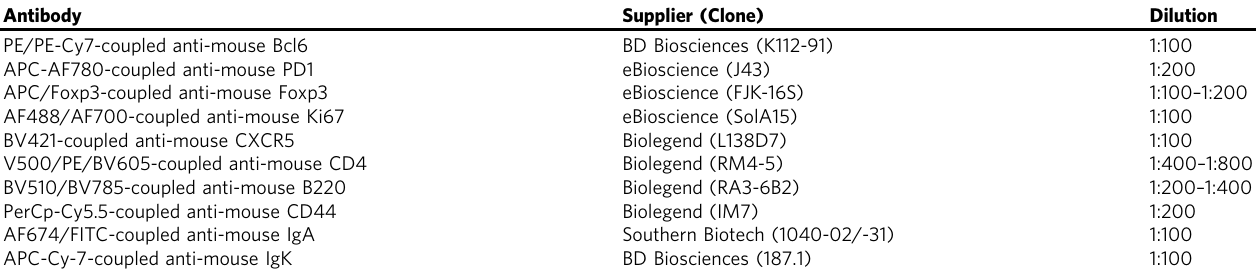
Table 1 List of antibodies used for fl ow cytometry